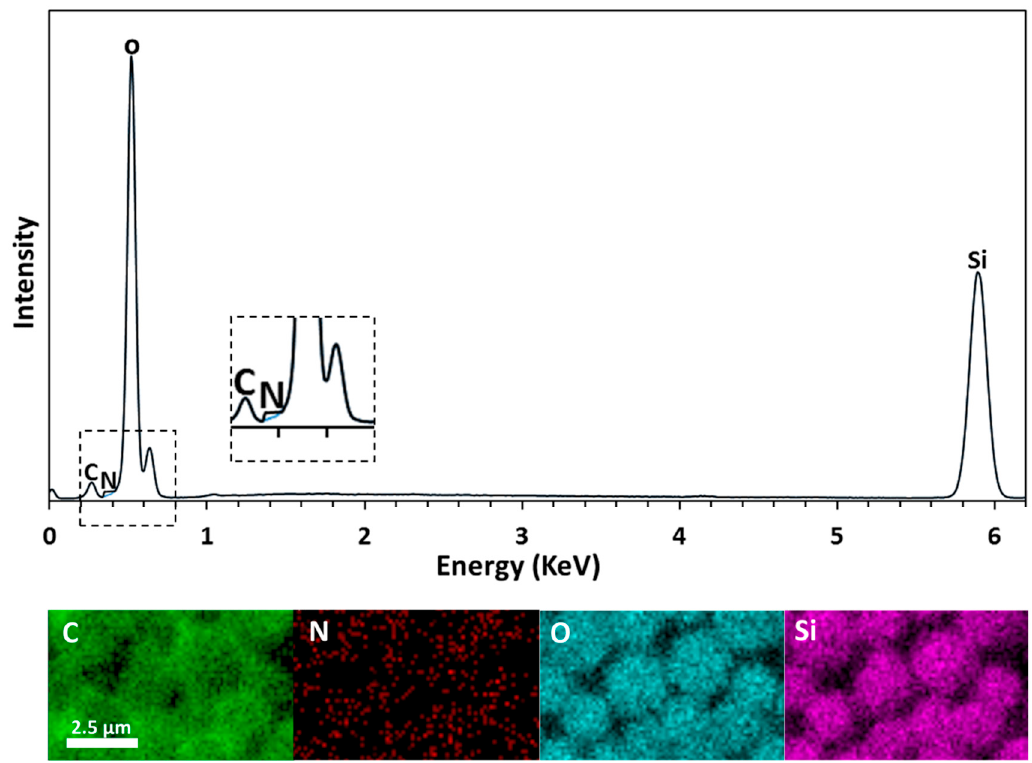
Figure 5. ( Upper )—EDX curve of PC/PMSQ-NH 2 (black) and of PC/PMSQ (blue). ( Lower )—2d map representation of PC/PMSQ-NH 2 microsphere.